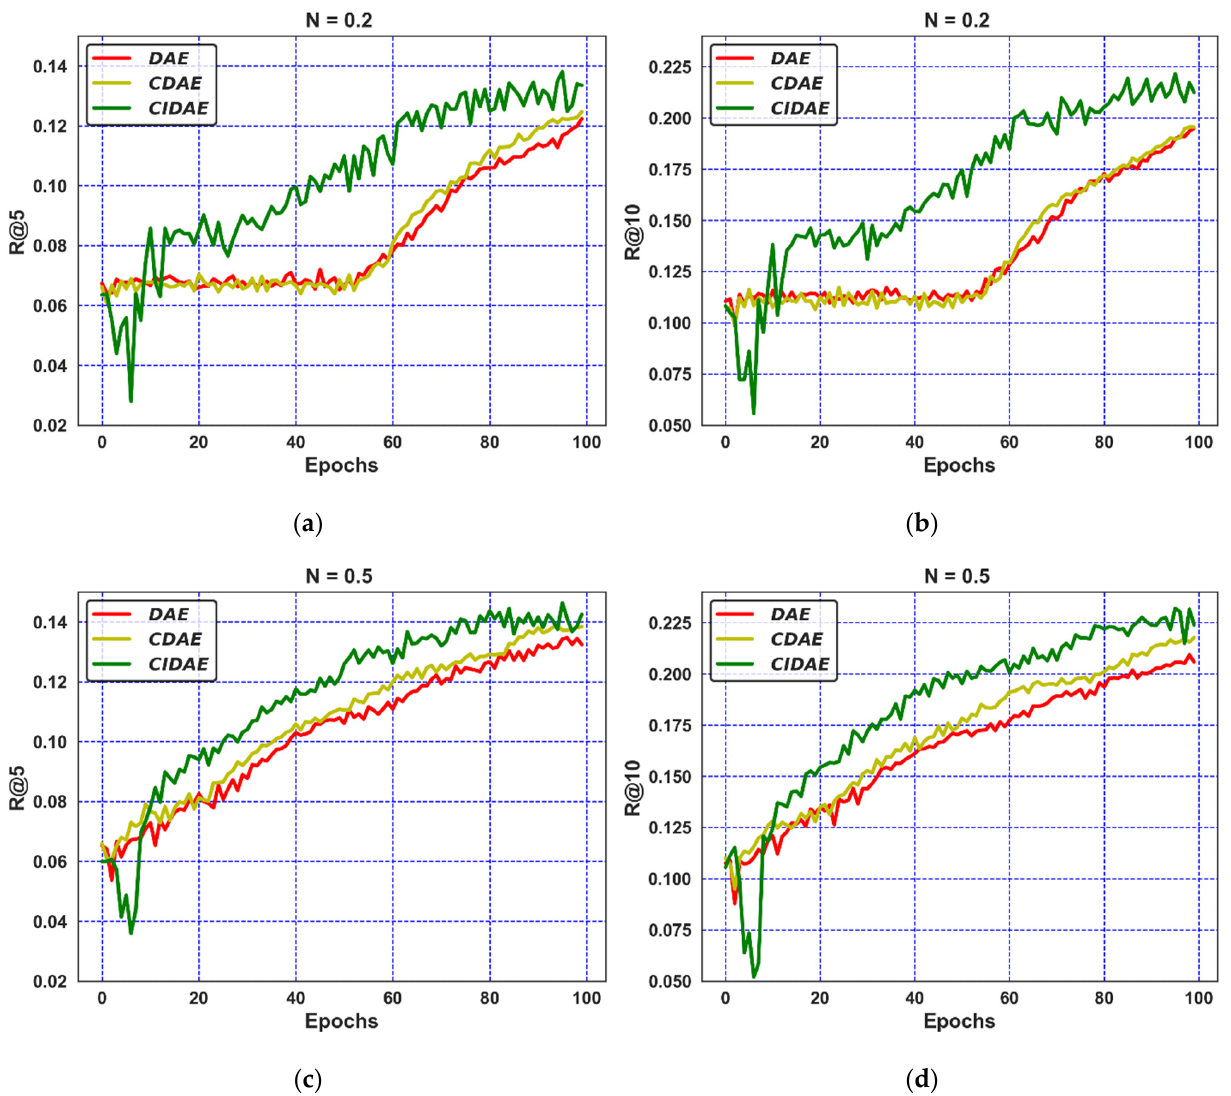
Figure 7. Performance comparison on ML ‐ 100K through Recall R@5 and R@10 metrics.